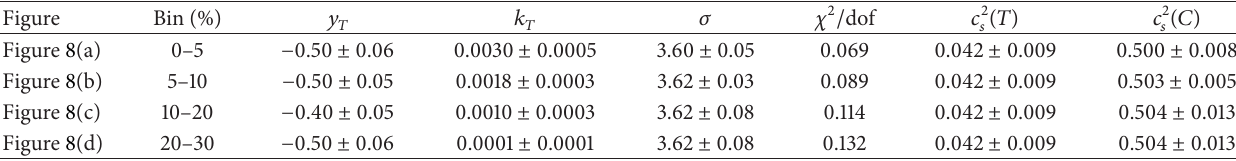
Table 3: This table is just like Table 1 but is showing the results for the curves in Figure 8 which shows Pb-Pb collisions at 2.76 TeV with different centralities. The values of 𝑘 𝑇 are very small and can be neglected in the